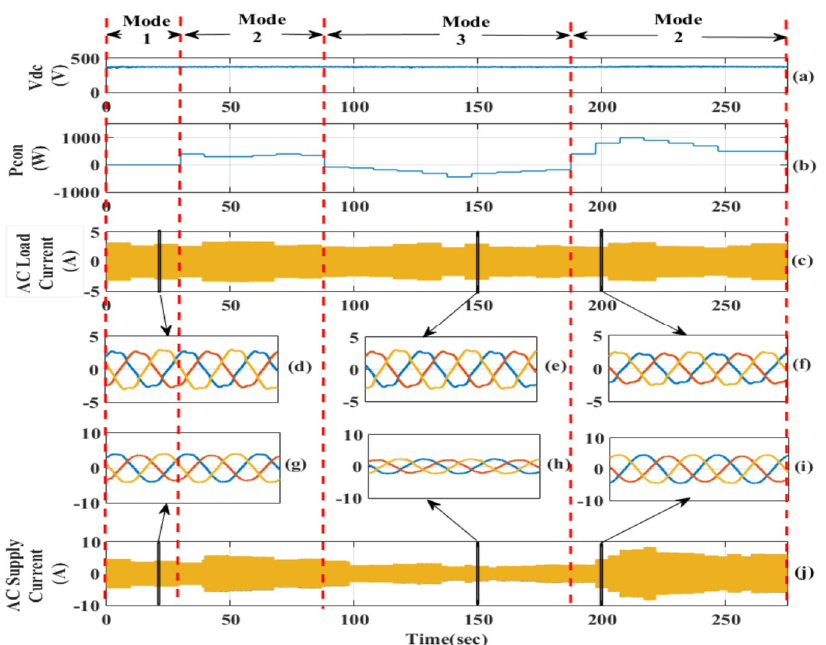
Figure 9. Experimental setup block diagram.